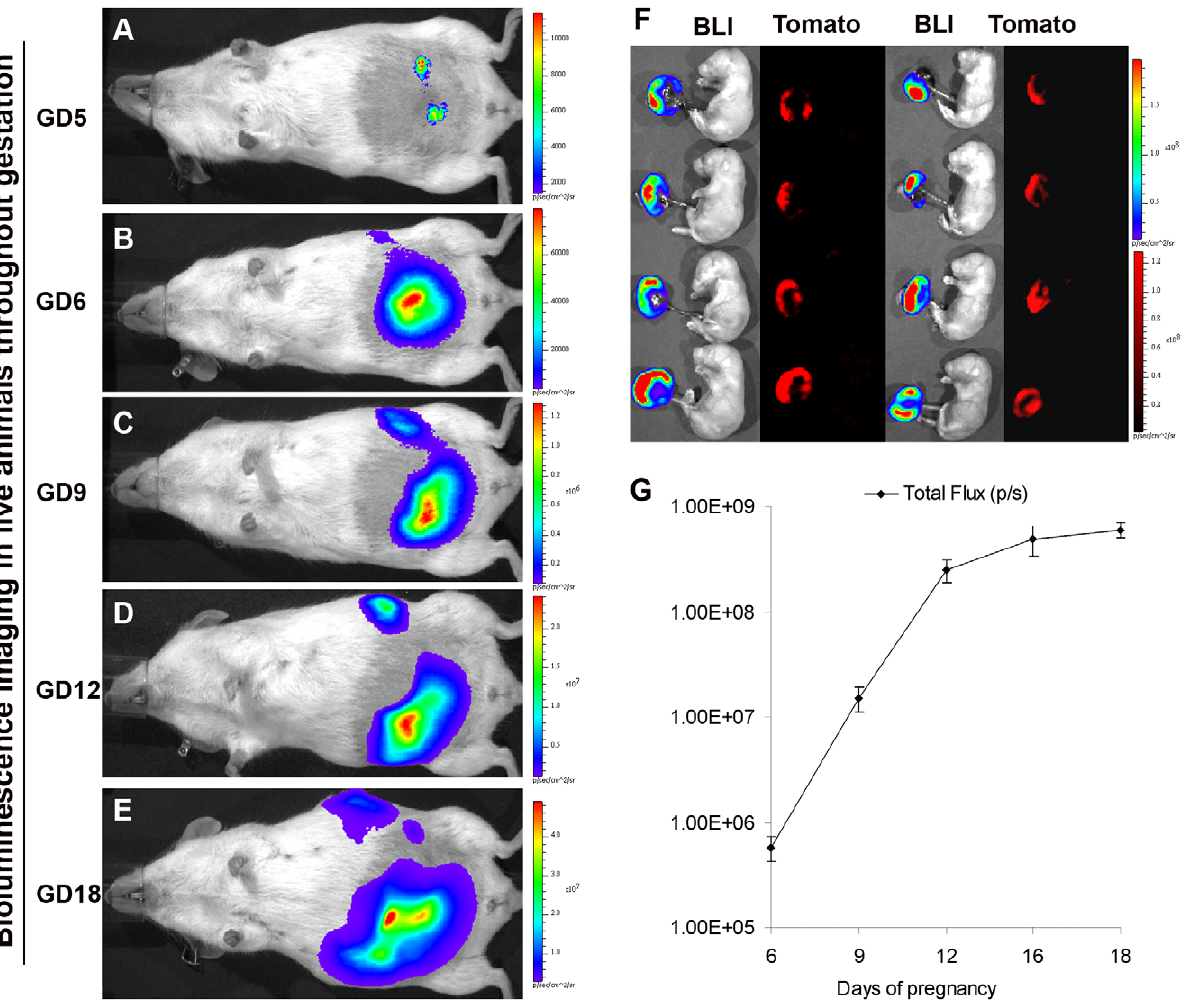
Figure 2. Trophoblast-specific Fluc expression assessed by live BLI at different stages of pregnancy. Blastocysts (selected) optimally transduced with LV-Fluc/Tomato were transferred into GD3 pseudopregnant recipients and Fluc expression in the placenta was evaluated by BLI at different stages of pregnancy in the same animal. A–E, grayscale body surface images and pseudocolor luminescence images (blue - least intense, red - most intense) were superimposed; photons emitted from implanting blastocysts could be detected as early as GD5 (A). F, placenta-specific Fluc (BLI) and Tomato (fluorescence) expression on GD18. Note that fetuses of the corresponding placentas are both Fluc and Tomato negative, indicating viral transduction of trophoblast-specific lineage. G, levels of total photon flux over the abdominal area at different stages of pregnancy; there was an exponential increase in signal intensity from GD6 through GD12.